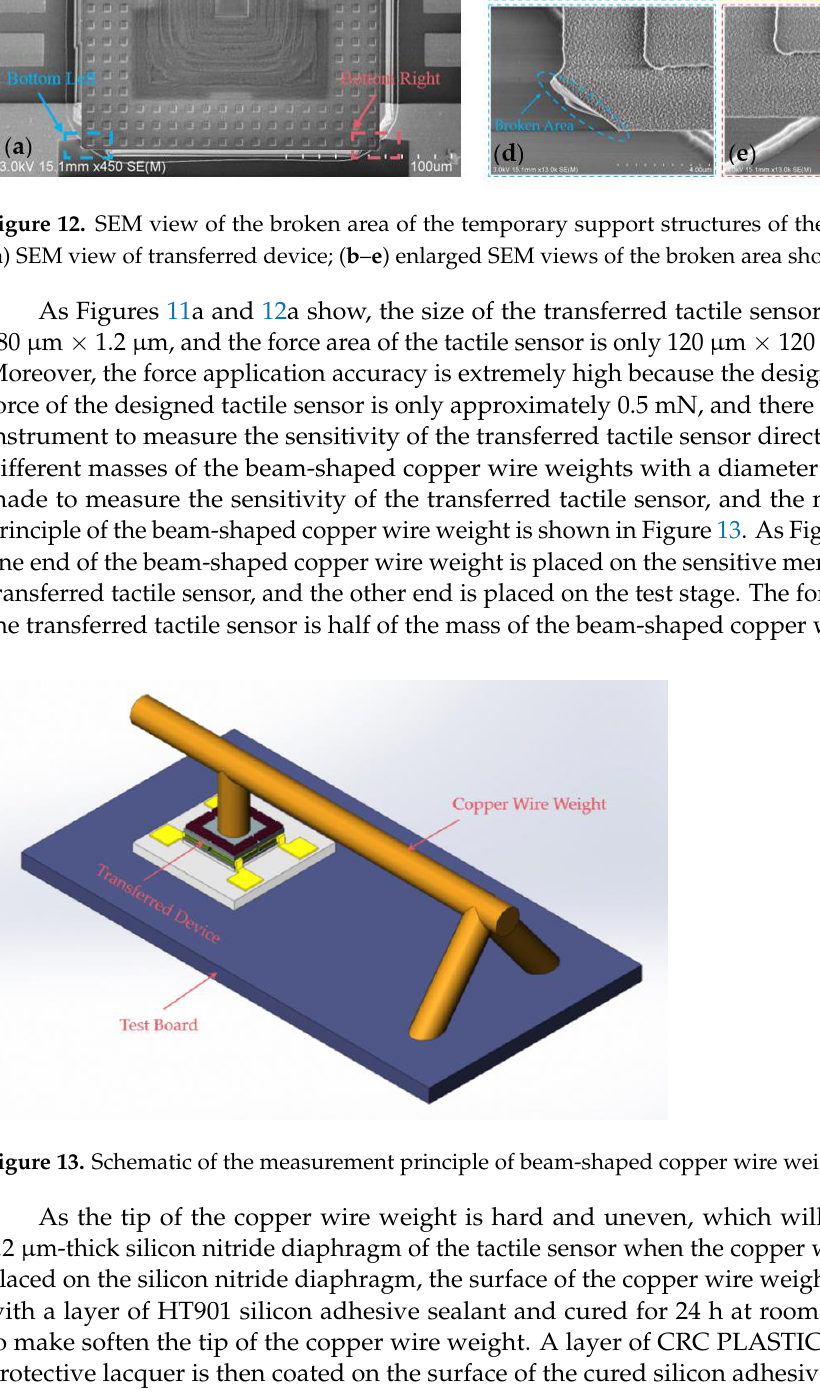
sealant cured for 12 h at room temperature to prevent the adhesive force of the silicon adhesive